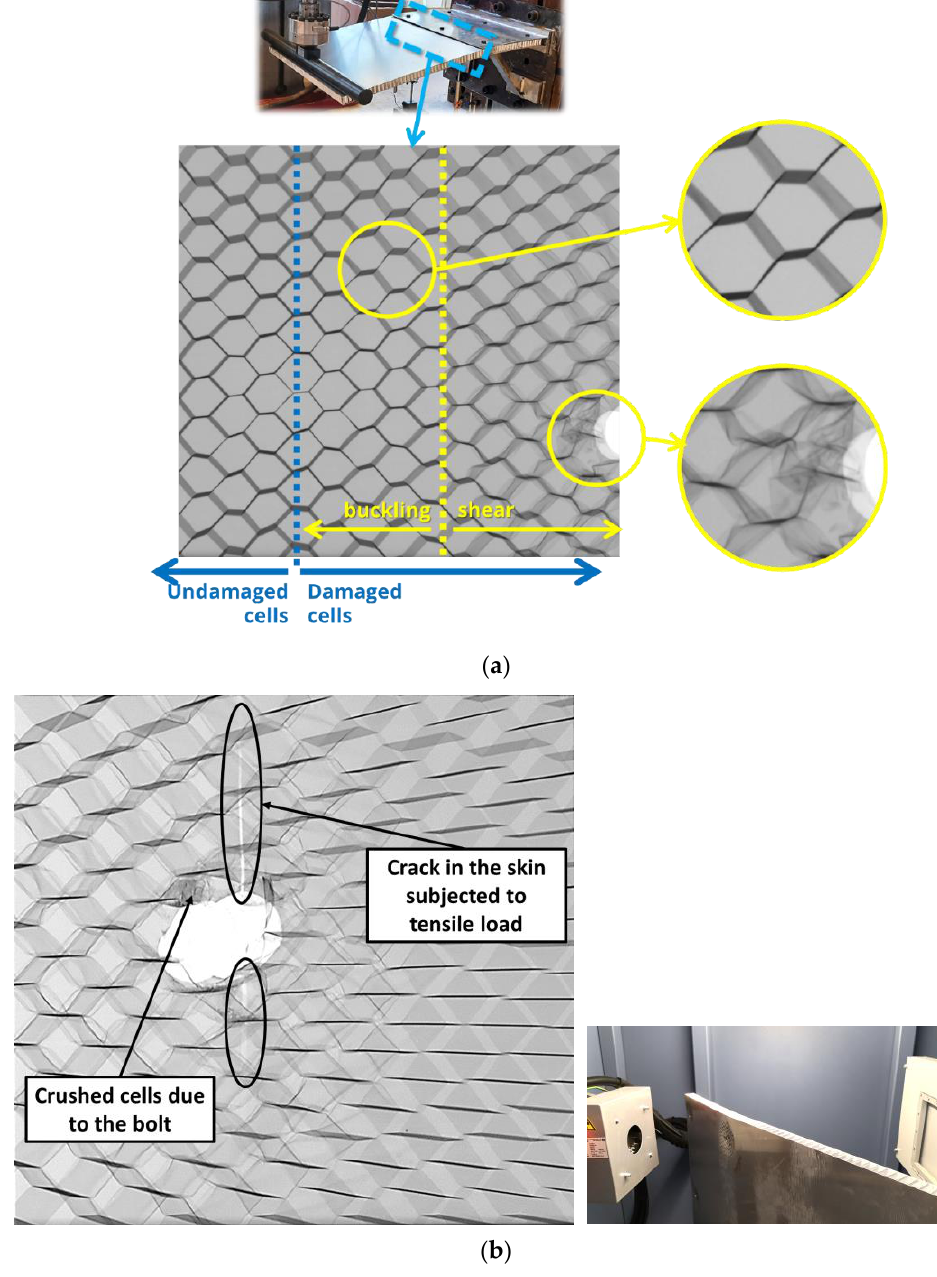
Figure 15. Images obtained by non-destructive radiographic inspection: ( a ) identification of undam- aged and damaged areas, with evidence of cell walls failed after buckling or shear; ( b ) detail of crushed cells and crack crossing the skin between holes for bolts.